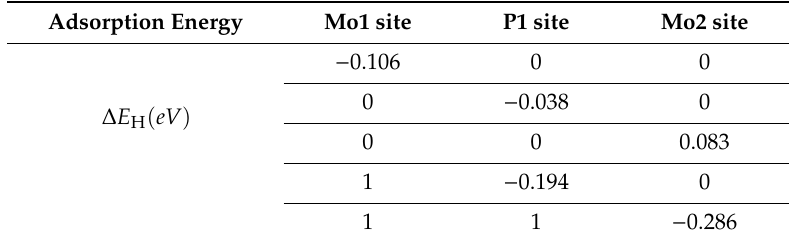
Table 4. Adsorption energies at the Mo1, P1 and Mo2 sites. Here, 1 means there is an adsorbed H atom, while 0 stands for 0 adsorbed H